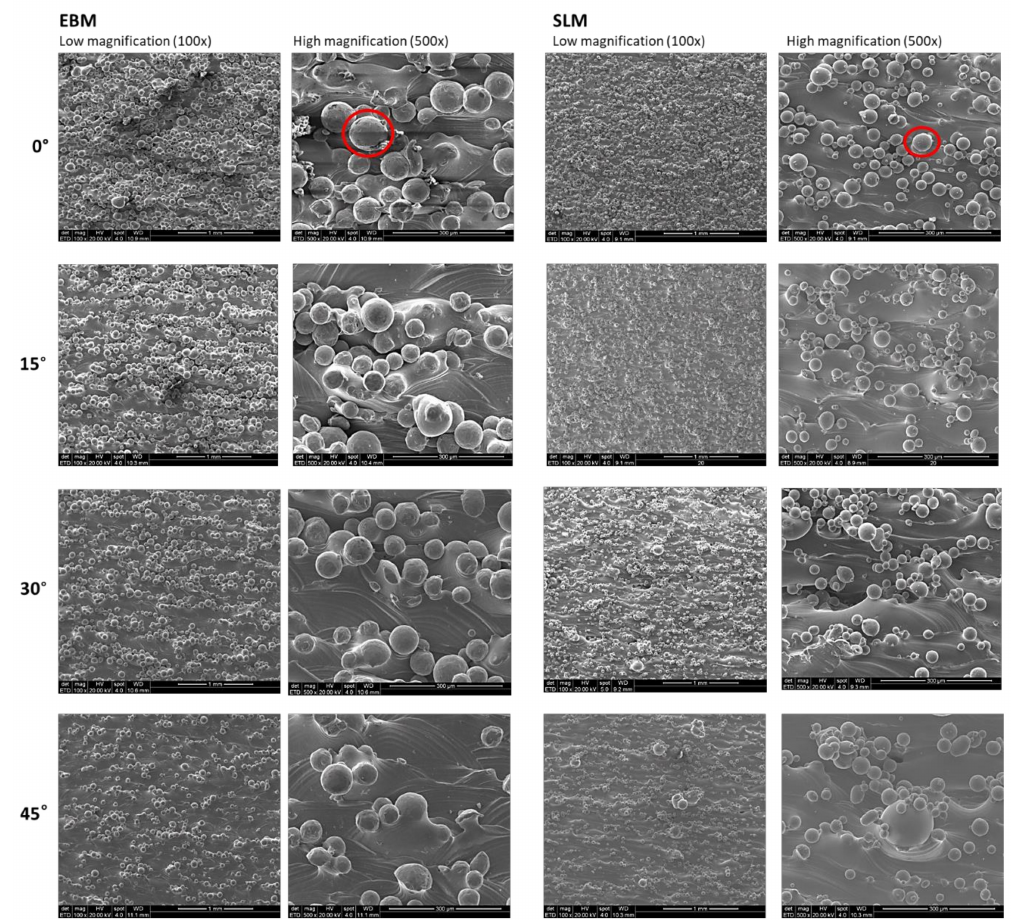
Figure 2. Micrographs illustrating the topography of the as-built surfaces of Ti6Al4V parts manufactured by EBM and SLM at 0 ◦ , 15 ◦ , 30 ◦ , and 45 ◦ . Red cycles highlight the partially melted particles.